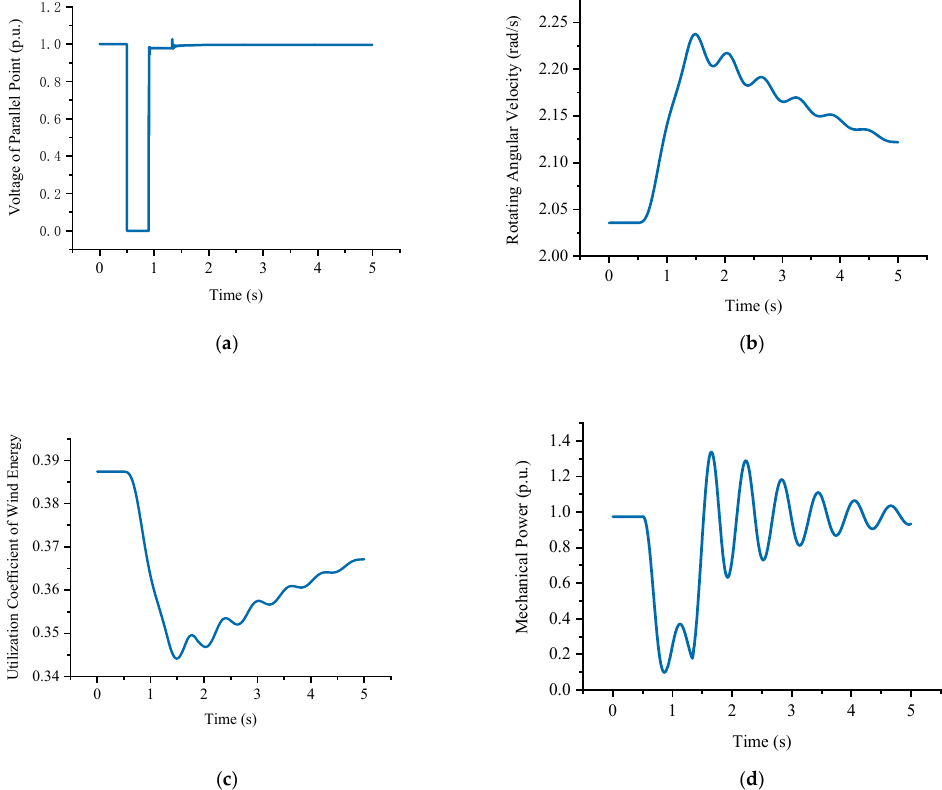
Figure 14. Wind turbine system. ( a ) Voltage drop curve of parallel point of the doubly fed wind turbine; ( b ) the rotating angular velocity of the wind turbine; ( c ) the utilization coefficient of wind energy; ( d ) mechanical power on the shaft.